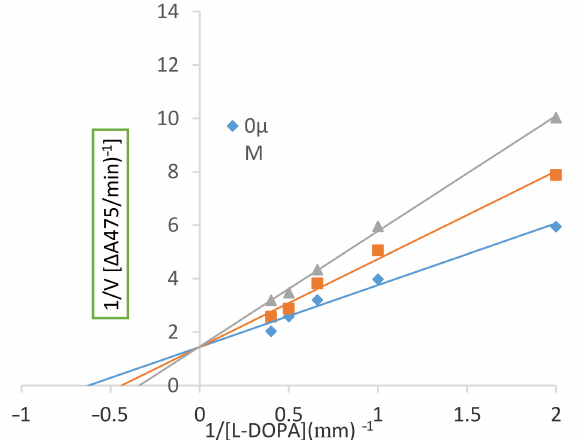
Figure 6. Inhibition of compound 1c —Lineweaver–Burk plot.